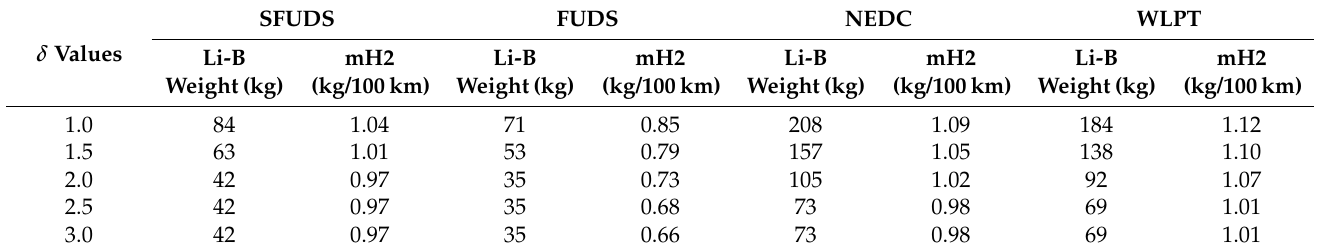
Table 8. Effect of δ on the sizing procedure